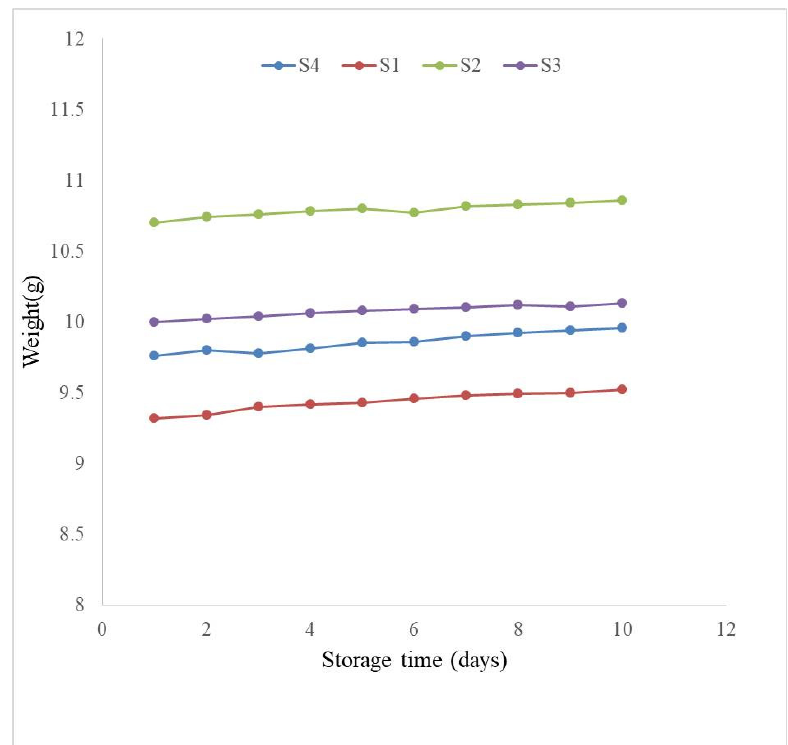
Figure 2. Changes in weight of control and Aloe Vera leaf powder (ALP) incorporated plain cakes during storage period at room temperature (30 ± 2 °C) .